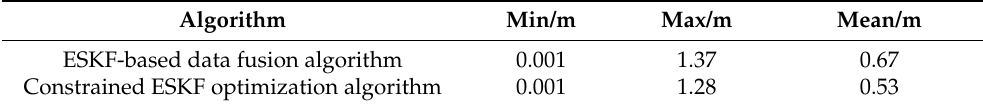
Table 4. Comparisons of errors of three